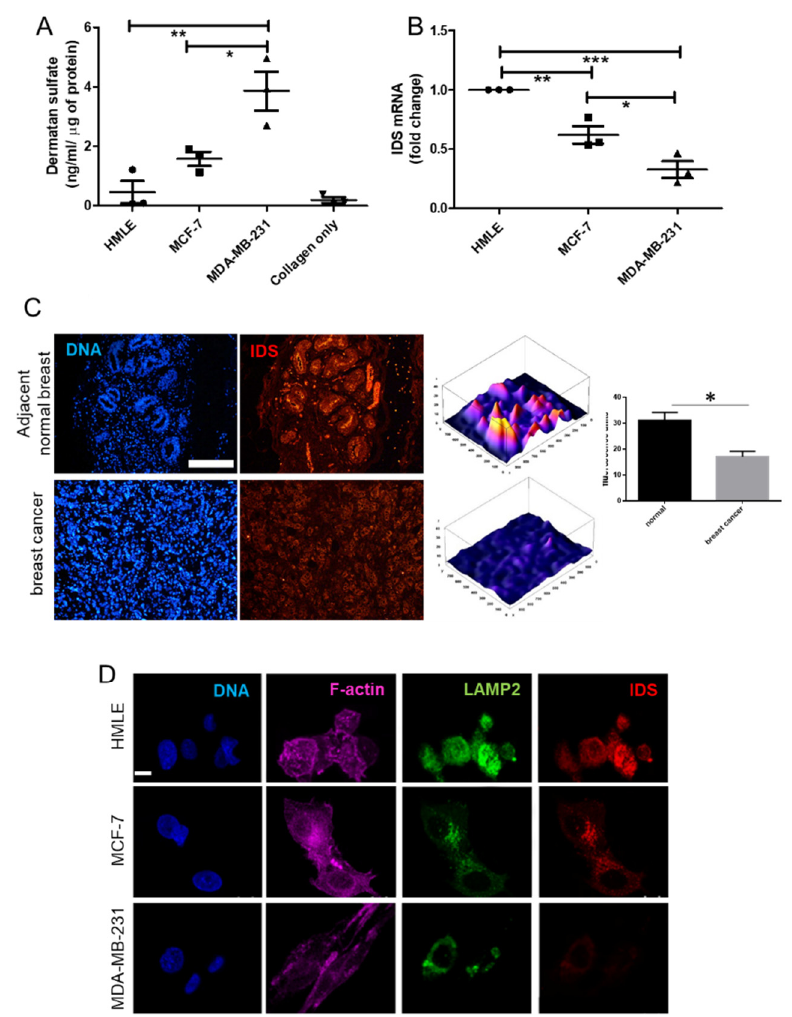
Figure 2. Levels of iduronate-2 sulfatase (IDS) are decreased in cancer epithelia in vivo and in culture. ( A ) Scatter plot of dermatan sulfate (DS) levels normalized to total protein measured using ELISA in HMLE, MCF-7 and MDA-MB-231 cells cultured in 3D Type 1 collagen scaffolds. ( B ) Scatter plot of IDS mRNA levels in HMLE, MCF-7 and MDA-MB-231 cells cultured in 3D Type 1 collagen scaffolds, as determined by real time PCR with 18S rRNA as internal control. ( C ) (left) Epifluorescence micrographs of matched normal breast sections (top) and breast cancer tissues (bottom) stained for DNA (using DAPI; blue), and IDS (using antibody; red), scale = 200 μ m. (middle) 3D profile plots of IDS levels in normal (top) and cancer (bottom) sections with bright colored peaks showing higher staining for IDS in nontransformed cells. (right) Bar graph showing a statistically significant decrease in IDS levels in breast cancer tissues compared with adjacent breast epithelial cells (50 cells, 5 fields, 2 sample sets). ( D ) Confocal micrographs of HMLE, MCF-7 and MDA-MB-231 cells cultured on top of Type 1 collagen scaffolds and stained for DNA (with DAPI; blue), F-actin (with phalloidin; pink), acidic compartment (with antibody against LAMP2; green), and for IDS (antibody; red), scale = 20 µ m. Significance was measured using one-way ANOVA and student’s t test (* p < 0.05, ** p < 0.01, *** p < 0.001).